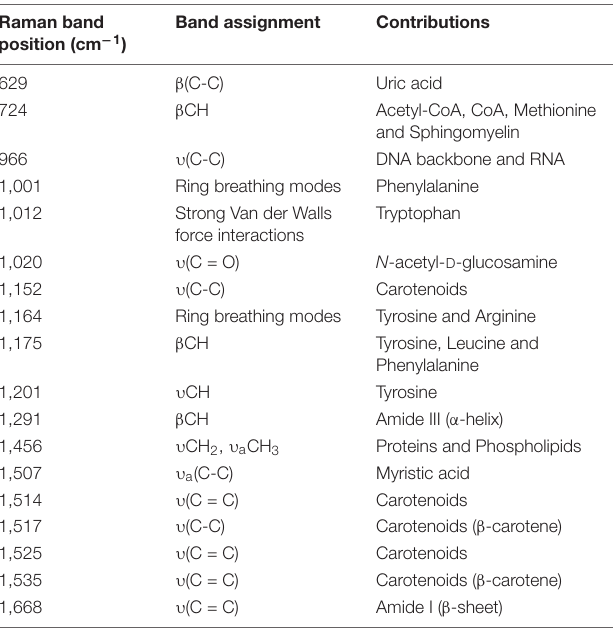
TABLE 1 | Raman bands position, their respective assignments and contributors. Raman band position (cm − 1